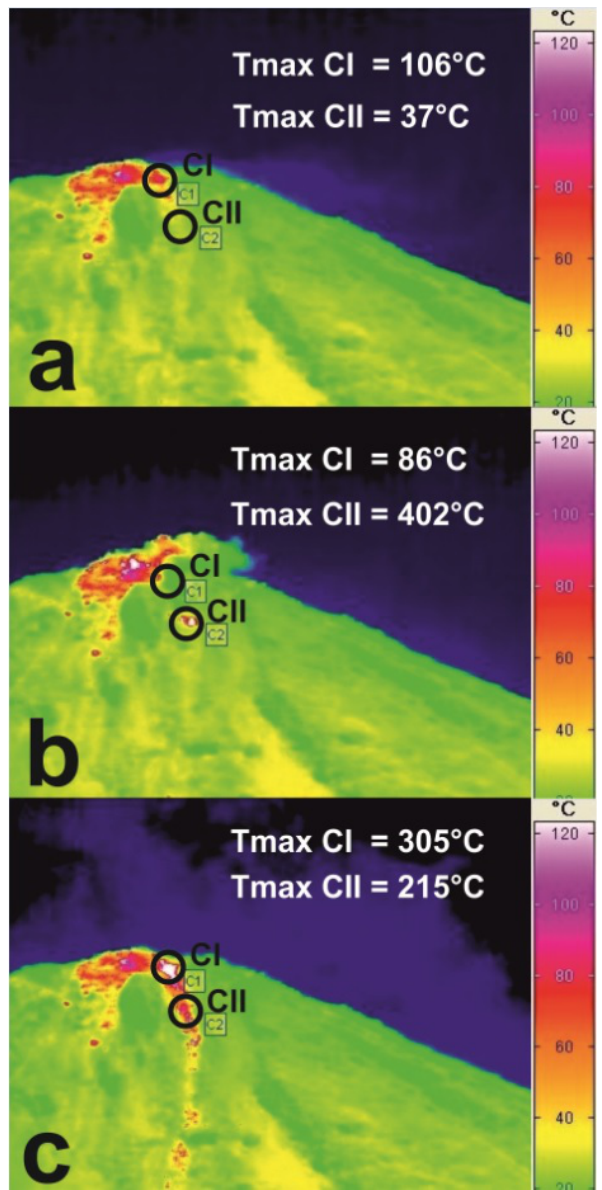
Fig. 5. Series of thermal images of a rockfall on 9 March, 2011 at 21:07 GMT at Volc´an de Colima before (a) , during (b) and after (c) a rockfall. The black circle C1 marks the exposed face on the dome; C2 marks a spot on the slope where the rockfall will pass by. Each picture shows the maximum temperature of each circle which is the basis for the temperature difference measurements. Tempera- ture scales were fixed to better show the distribution of lower tem- peratures; white areas have temperatures up to 400 ◦ C.